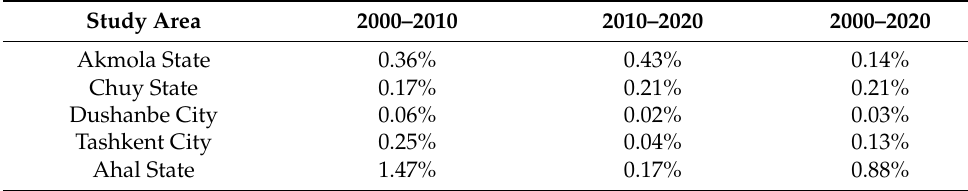
Table 1. Dynamic degree of integrated land use. Study